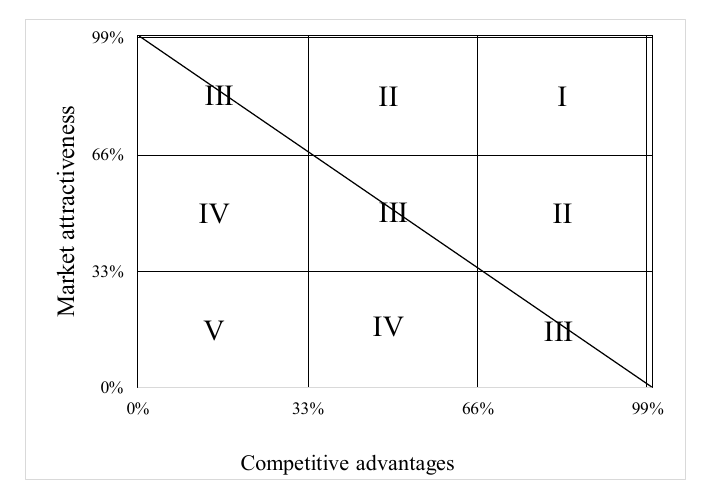
Fig. 2. “Market attractiveness – competitive advantages” matrix, or the GE-McKinsey Matrix [8],